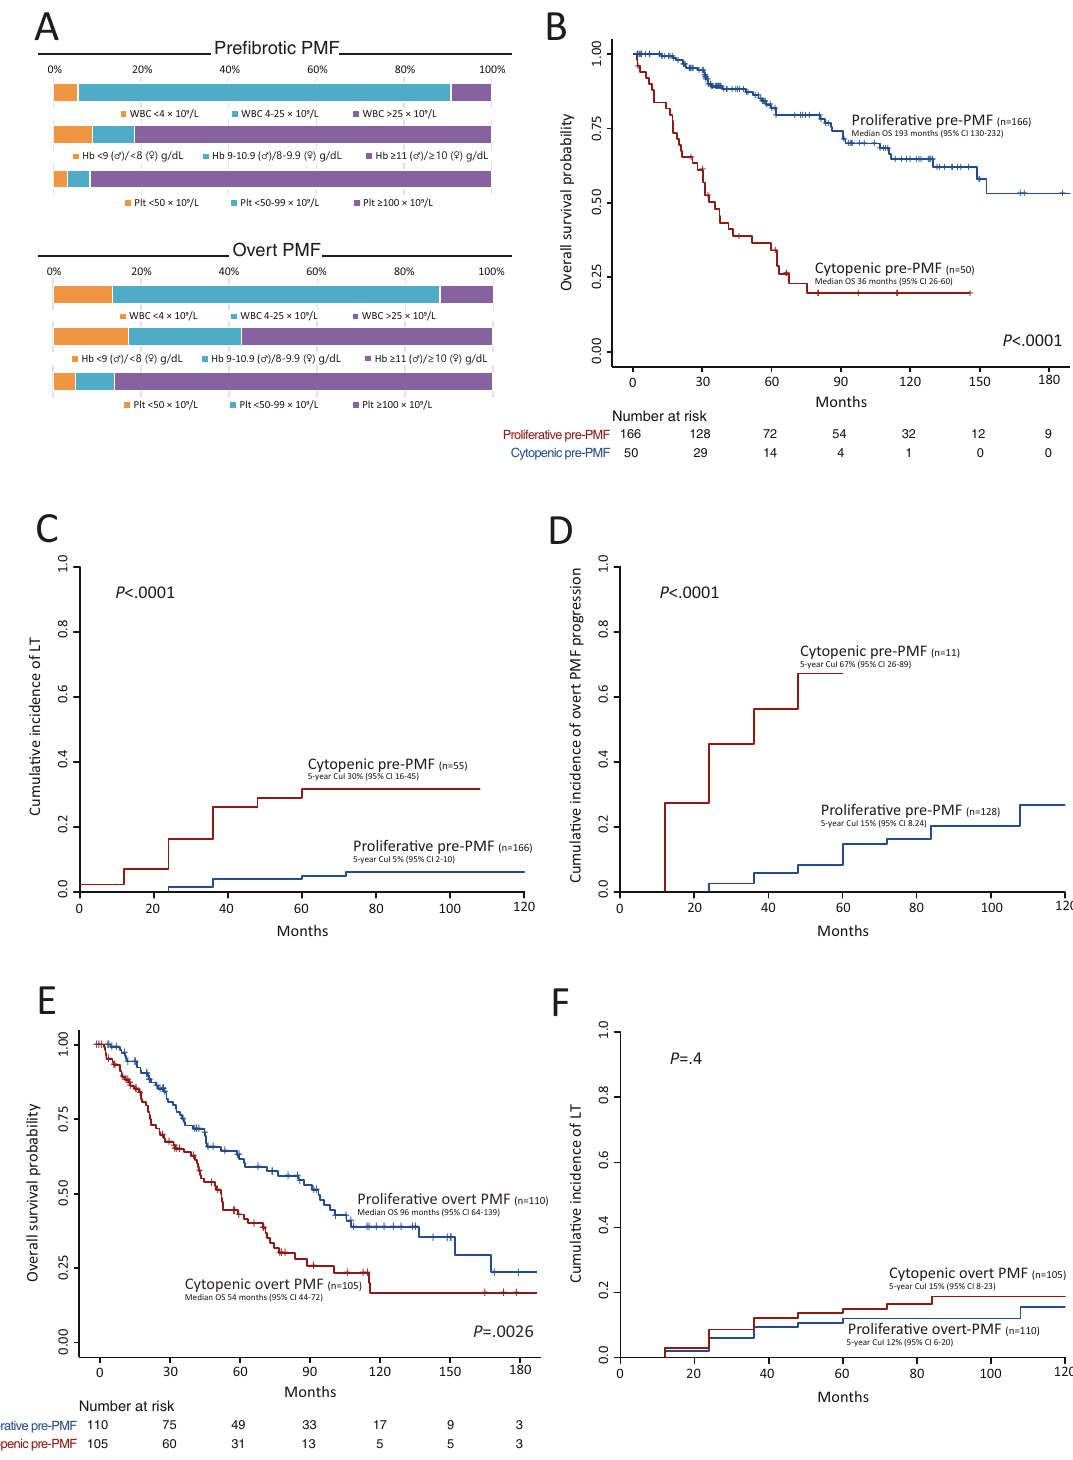
Fig. 1 Characteristics and outcomes of patients with pre fi brotic and overt PMF according to disease phenotype (cytopenic vs proliferative). A Bar graph reporting the distribution of peripheral blood cell counts in pre-PMF (top) and overt PMF (bottom). B Kaplan-Meier estimates of overall survival in patients with pre-PMF according to disease phenotype (cytopenic vs proliferative). C Competing risks-adjusted estimates of cumulative incidence of leukemic transformation in pre-PMF according to disease phenotype (cytopenic vs proliferative). D Competing risks-adjusted estimates of cumulative incidence of progression to overtly fi brotic phase in 139 pre-PMF patients according to disease phenotype (cytopenic vs proliferative). E . Kaplan-Meier estimates of overall survival in patients with overt PMF according to disease phenotype (cytopenic vs proliferative). F Competing risks-adjusted estimates of cumulative incidence of leukemic transformation in overt PMF according to disease phenotype (cytopenic vs proliferative). Abbreviations: CI con fi dence interval, CuI cumulative incidence, Hb hemoglobin, LT leukemic transformation, OS overall survival, Plt platelets, pre-PMF pre fi brotic primary myelo fi brosis, WBC white blood